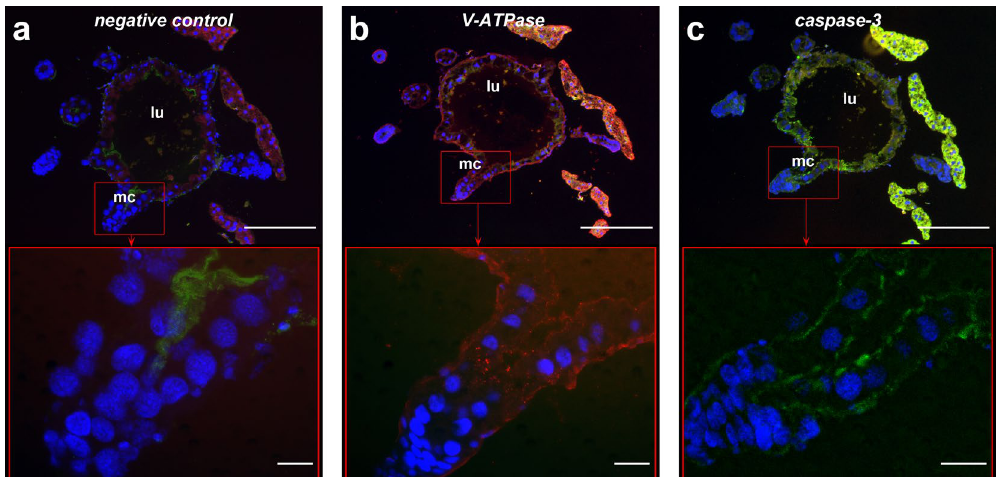
Figure 8. Immuno-localization of the caspase-3 active form and V-ATPase in sensitive S. oryzae (strain WAA42) intoxicated with PA1b. Midguts of the sensitive weevil WAA42 were dissected, embedded, frozen and then tissue sections (7 µ m) were cut. Slides were prepared as described in the Experimental Procedures section. Caspase-3 was labelled with rabbit anti-cleaved caspase-3 and V-ATPase was labelled with a rabbit anti-ductin antibody. Revelation of both antibodies was performed using a secondary antibody Alexa fluor 488 donkey anti- rabbit IgG. To compare the labelling of caspase-3 and V-ATPase, labelling was performed on successive cuts and the green signal of anti-V-ATPase was transformed into a red signal. DAPI was added for nuclear staining. ( a ) negative control (non-immune serum); ( b ) anti-V-ATPase antibody labelling and ( c ) anti-caspase-3 antibody labelling. Upper panel scale bar = 200 µ m; lower panel scale bar = 20 µ m. Blue: nuclei stained with DAPI; green: caspase 3; red: